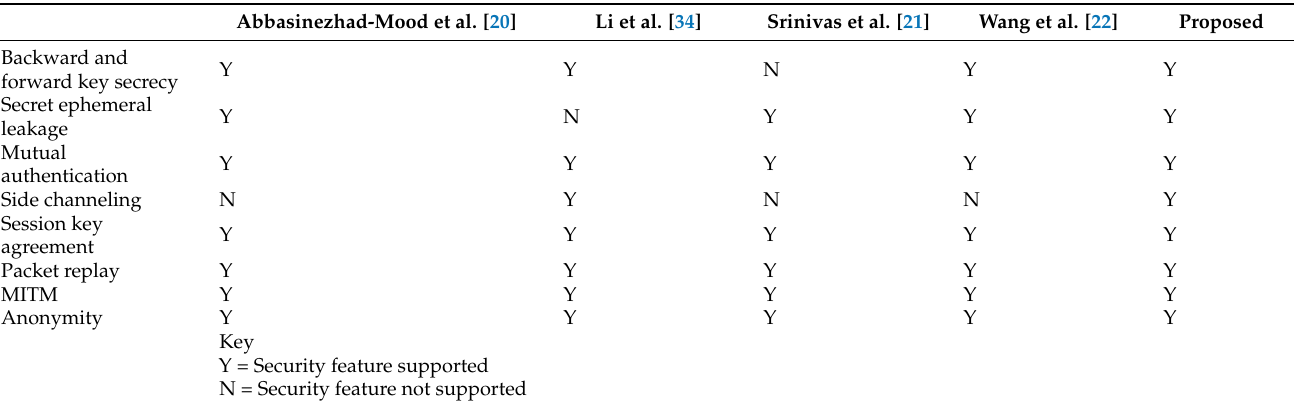
Table 6. Security features